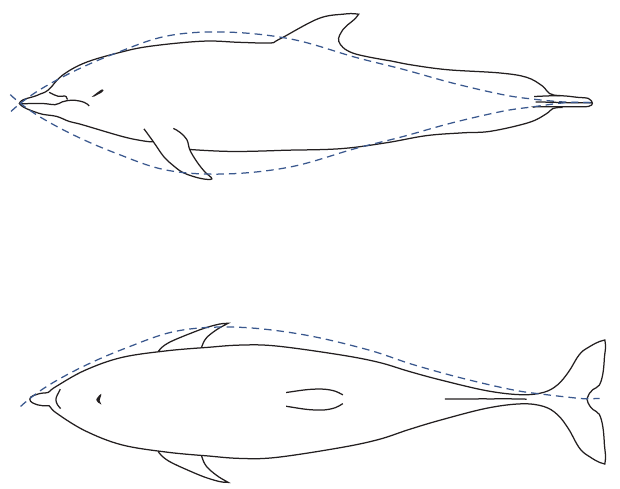
Figure 1: Comparison of the shape UA-2c with the body of a bottlenose dolphin [9].